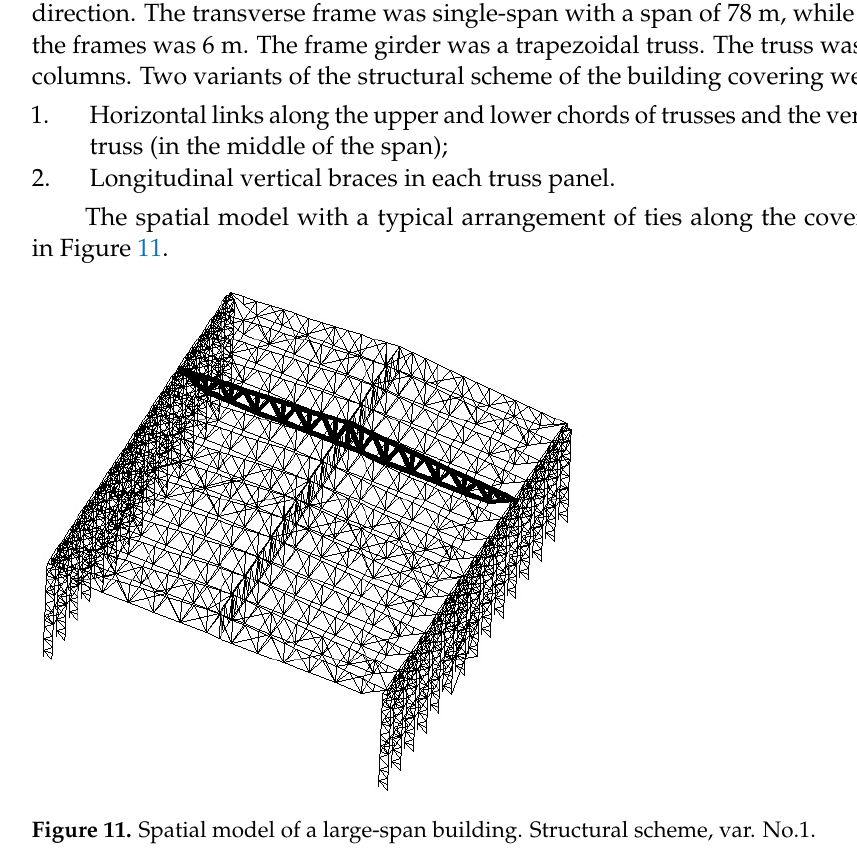
Figure 11. Spatial model of a large-span building. Structural scheme, var.